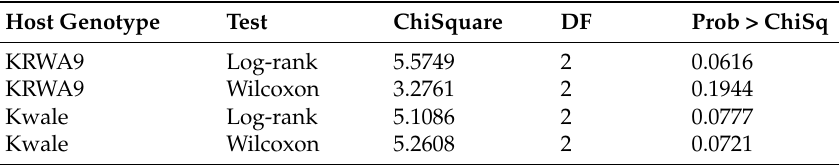
Table 3. Effect of host genotype on development time of RWA from 1st to 4th instar development stages. Development Time (Number of Days) Variety 1st Instar